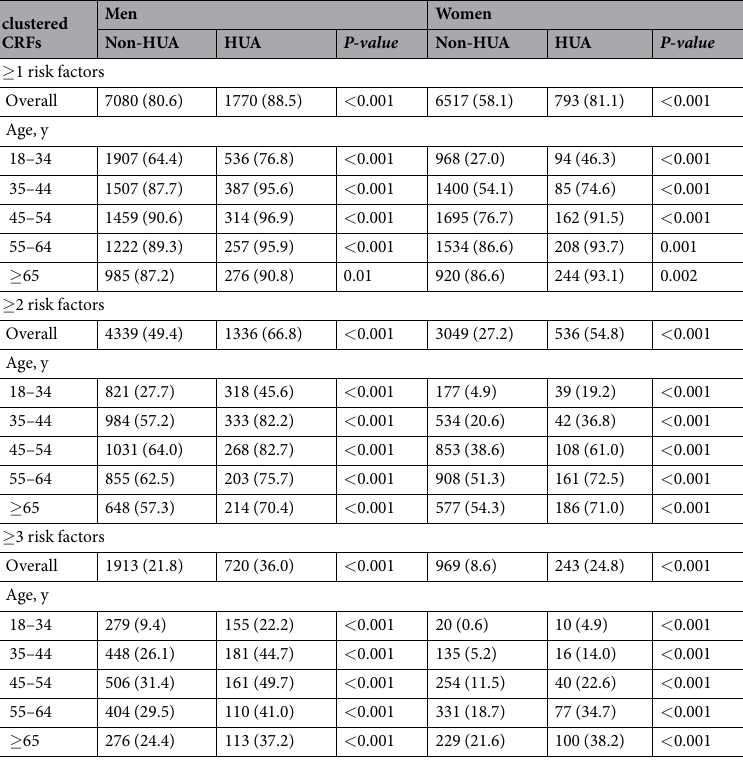
Table 3. Prevalence of clustered CRFs among participants by gender and age. Data are presented as N(percent prevalence). HUA, hyperuricemia; CRFs, cardiovascular risk factors.